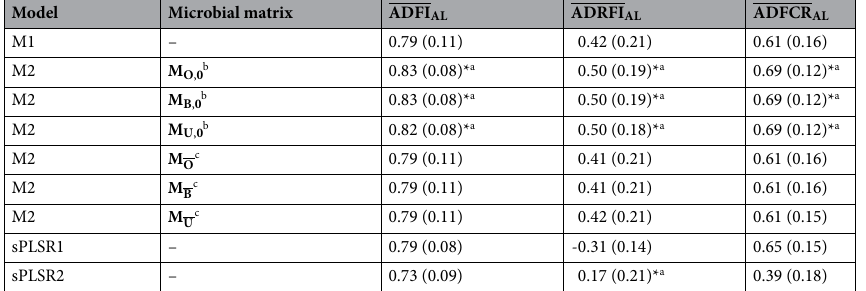
Table 6. Across 100 replicates average (SD) correlation coefficient between observed and predicted individual cage-average ADFI AL , ADRFI AL and ADFCRI AL records with sPLSR and mixed models using the fullDataset. ADFI AL , average daily feed intake in rabbits fed ad libitum; ADRFI AL , average daily residual feed intake in rabbits fed ad libitum; ADFCR AL , average daily feed conversion ratio in rabbits fed ad libitum; SD, standard deviation; M1, mixed model without microbial effects; M2, mixed model fitting the microbial effects; M O , microbial relationship covariance matrix defined from CSS normalized OTU counts, M B , microbial relationship covariance matrix defined from Bray–Curtis distance matrix; M U , microbial relationship covariance matrix defined from weighted Unifrac distance matrix; sPLS1, sparse Partial Least Squares Regression model with systematic effects as predictors; sPLS2, sparse Partial Least Squares Regression model with systematic effects and cage-average CSS OTU counts as predictors. *M2 or sPLSR2 correlation between observed and predicted records significantly higher (bootstrapped paired t test) than M1 or sPLSR1 correlation after false discovery rate correction for multiple testing at the P < 0.05 level. a M2 or sPLSR2 correlation between observed and predicted records higher than M1 or sPLSR1 correlation in at least 80% of the replicates. b The expansion of the microbial relationship matrix ( M O , M B or M U ) was done by including ones in the diagonal and zeros outside the diagonal for the animals without microbial information. c The expansion of the microbial relationship matrix ( M O , M B or M U ) was done before computing the respective distance matrices, assigning to the animals without microbial information the cage-average of the CSS normalized OTU